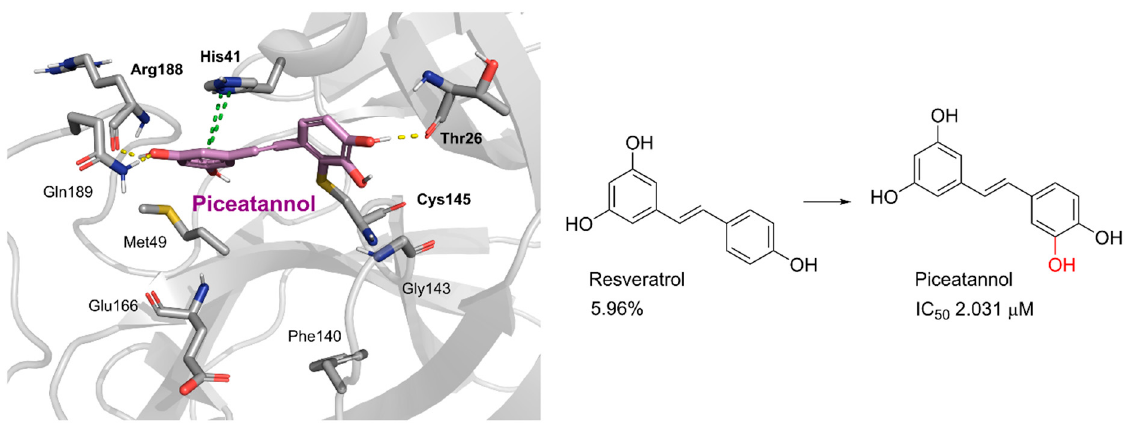
Figure 6. Docking study of piceatannol in the M pro binding site. Dashes represent different interaction types: green— π -stacking, yellow—polar contacts such as hydrogen bonds.